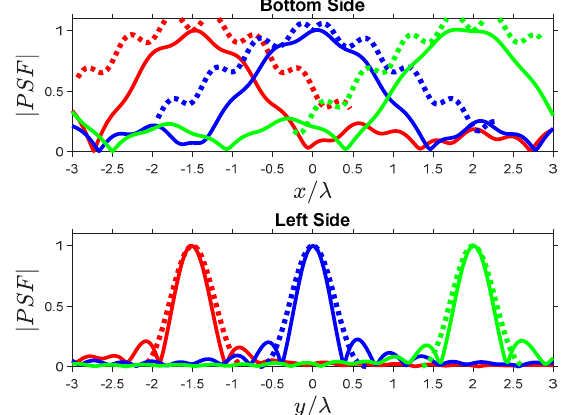
Figure 11. Comparison of the actual PSF (dotted lines) and approximated 𝑃𝑆𝐹(cid:3562) (solid lines) for the bottom and left sides in the reflection mode for 𝑥 (cid:2868) = −1.5𝜆 (red lines), 𝑥 (cid:2868) = 0𝜆 (blue lines), and 𝑥 (cid:2868) = 2𝜆 (green lines).